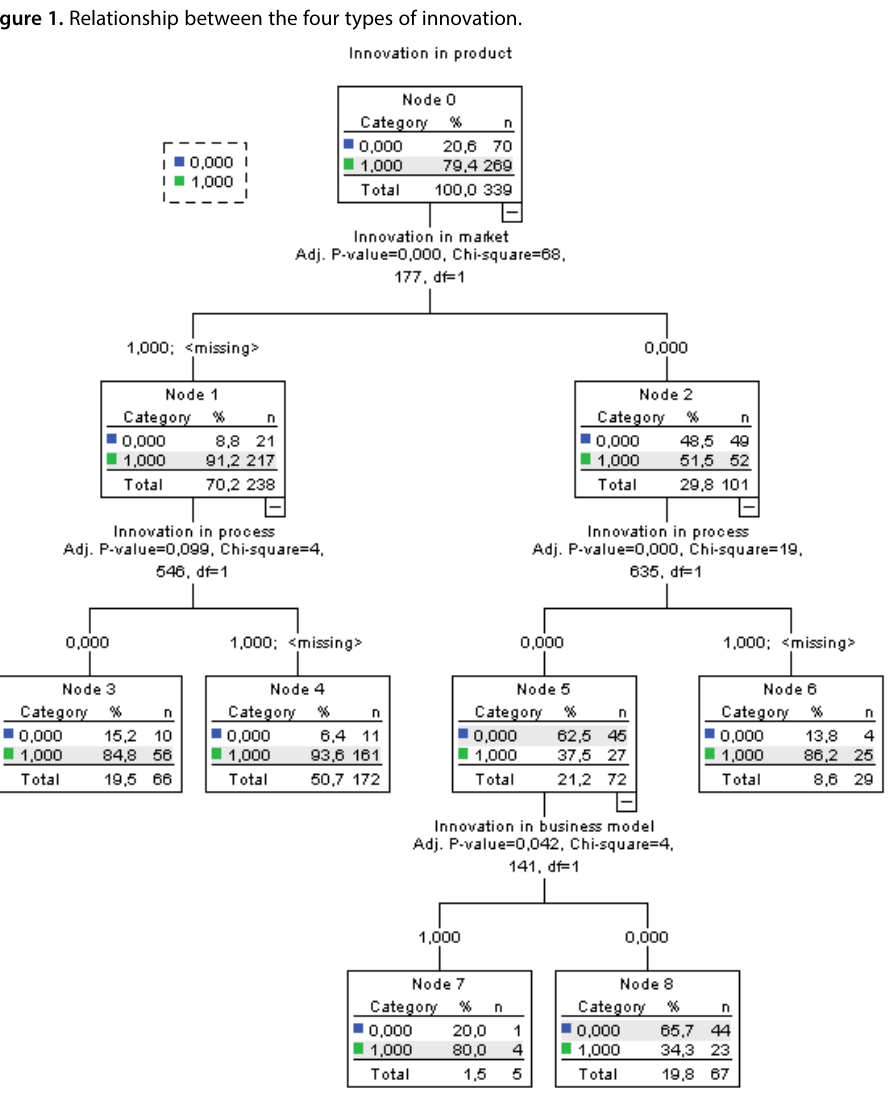
Figure 1. Relationship between the four types of